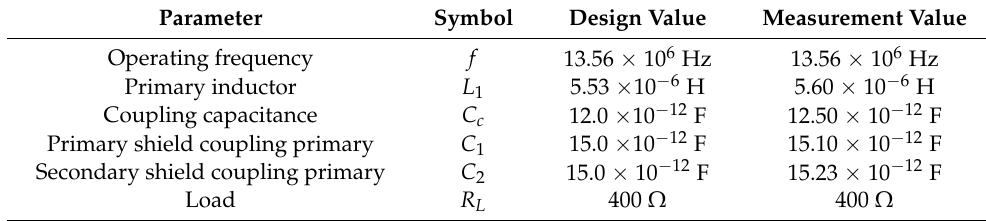
Table 3. Parameters of S-CPT based on the design value and measurement value.